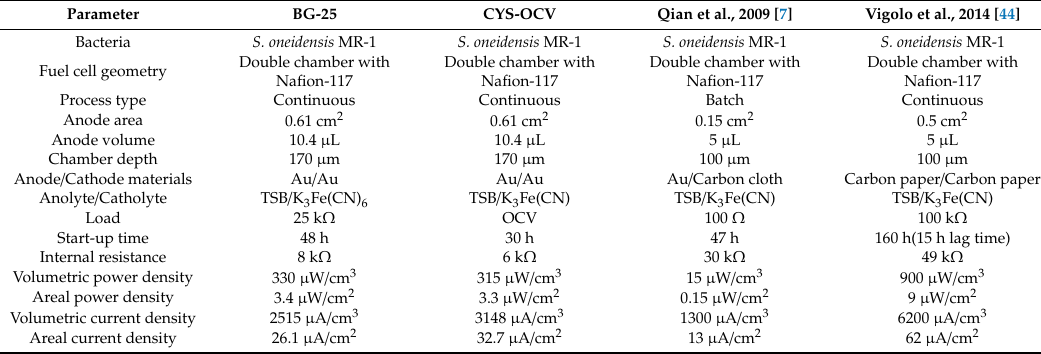
Table 4. Comparison of µ MFC systems with the